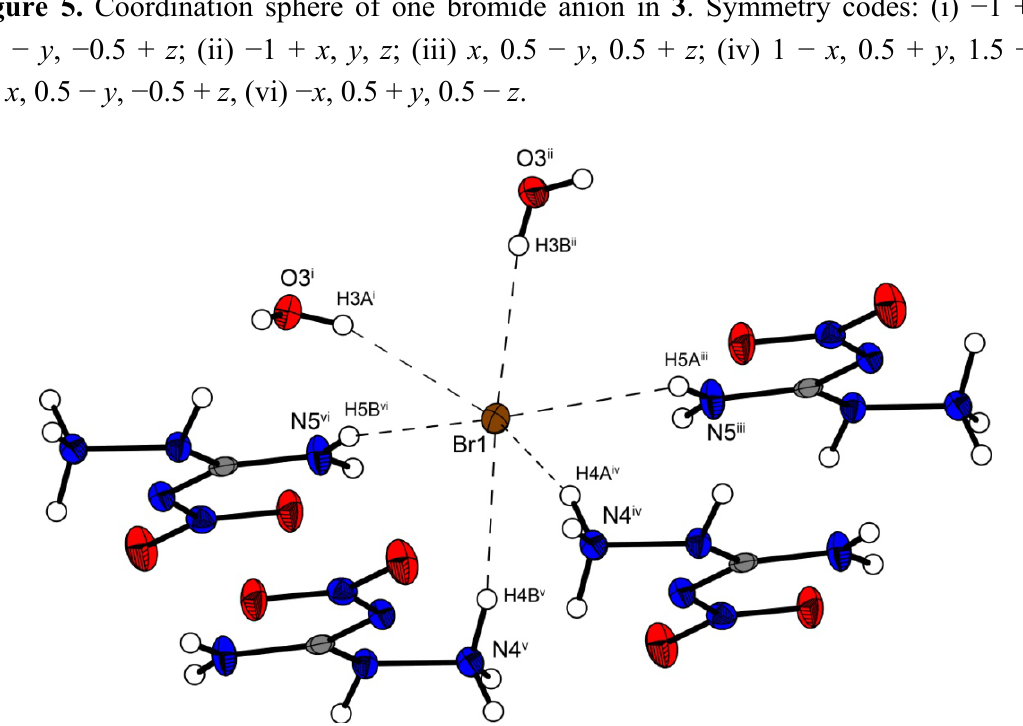
Table 5. Selected hydrogen bonds in the structure of 3 . Symmetry codes: (vi) 1 − x